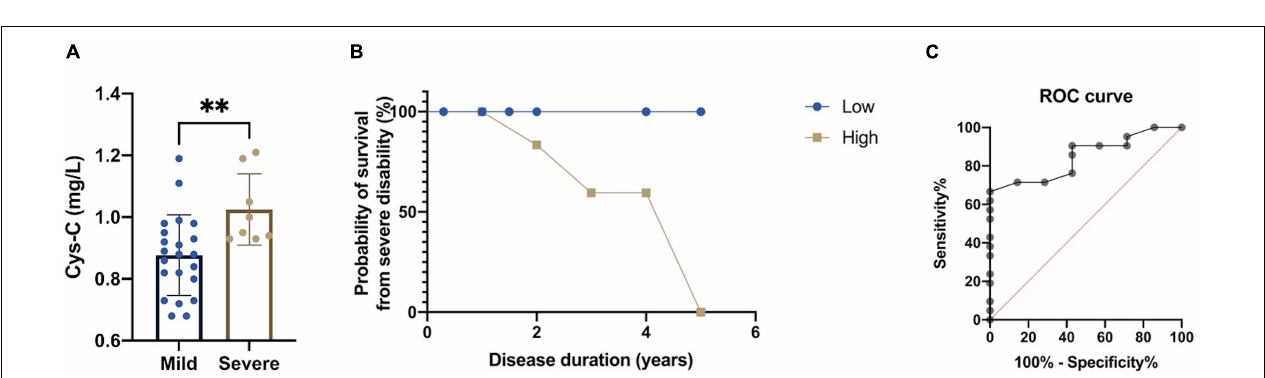
FIGURE 3 | Pearson correlation analyses of serum Cys-C levels in MSA patients and subgroups. (A) The serum levels of Cys-C were positively correlated to GDS in MSA patients ( r = 0.287, p = 0.039). (B) The serum levels of Cys-C were positively correlated to GDS in MSA-C patients ( r = 0.444, p = 0.018). (C) The serum levels of Cys-C were not correlated to GDS in MSA-P patients ( r = 0.118, p = 0.582).